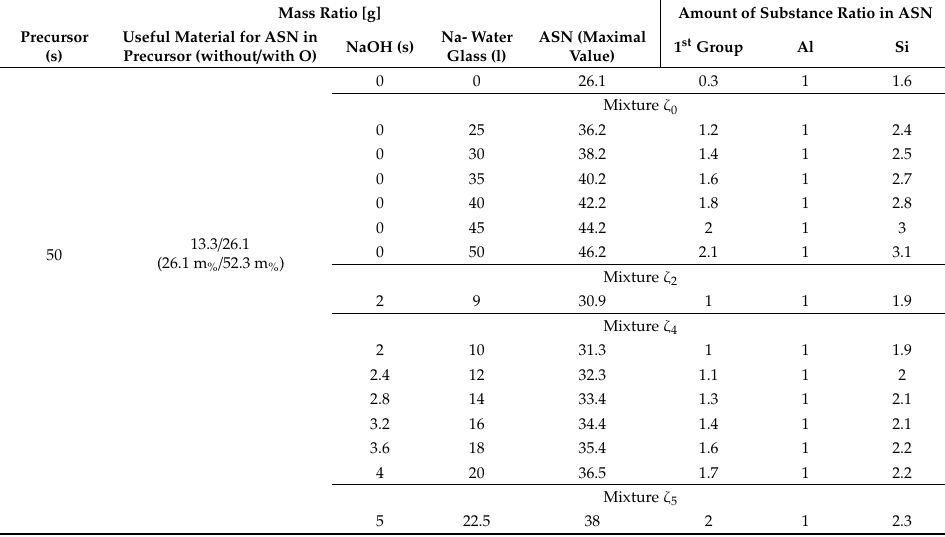
Table 4. Mass ratio of precursor with useful material in the precursor for AA ASN formation (without and with O), NaOH, Na-water glass, and maximal value of ASN (if all useful material in precursor, whole Na from NaOH and Na-water glass, and whole Si from Na-water glass is used for ASN formation). Amount of substance ratio of amorphous first group, Al and Si according to the chosen mass of precursor, NaOH, Na-water glass. Combination of ingredients for AA resulting close to the literature’s highest compressive strength value [34] is coloured orange, initial value present in the precursor is coloured grey. Mass Ratio [g] Amount of Substance Ratio in ASN Precursor Useful Material for ASN in Na- Water ASN (Maximal st Group (s) Precursor (without / with O) NaOH (s) Glass (l) Value) 1